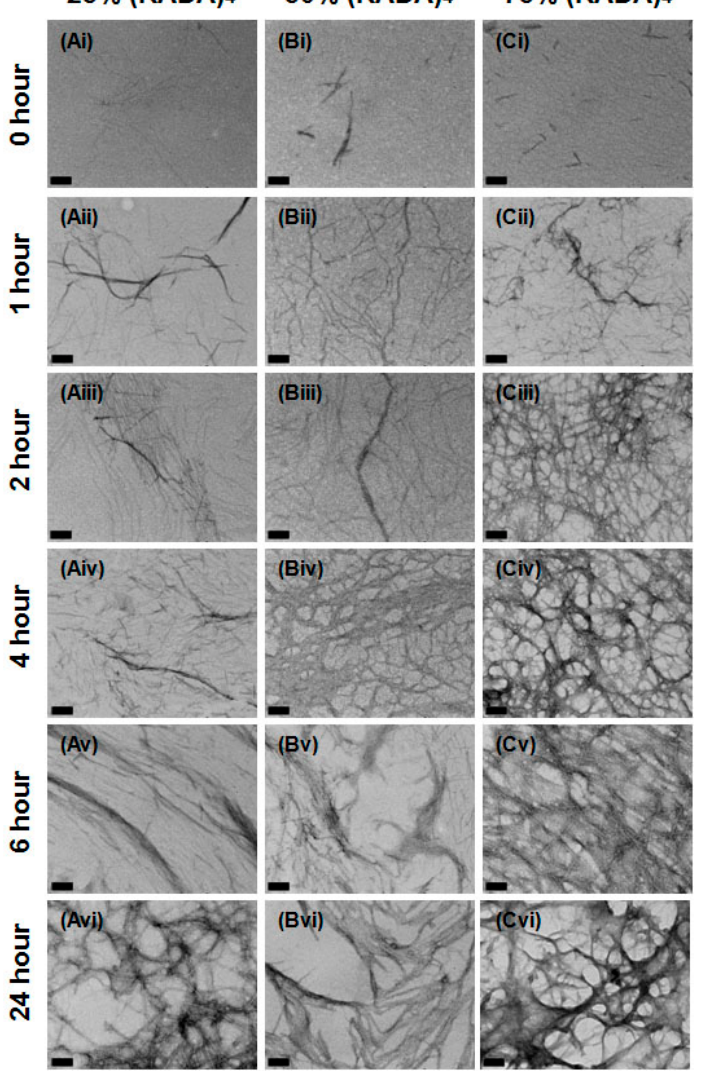
Figure 4. Transmission electron micrographs of ( A ) 25%/75%, ( B ) 50%/50%, and ( C ) 75%/25% (RADA)-GG-GPQG+IASQ/(RADA) 4 at ( i ) 0, ( ii ) 1, ( iii ) 2, ( iv ) 4, ( v ) 6, ( vi ) 24 h. All samples were stained with 4% uranyl acetate and imaged at 0.5% w / v in TNC buffer upon 30 min of sonication and incubation at 37 °C. Scale bars are all 100 nm.